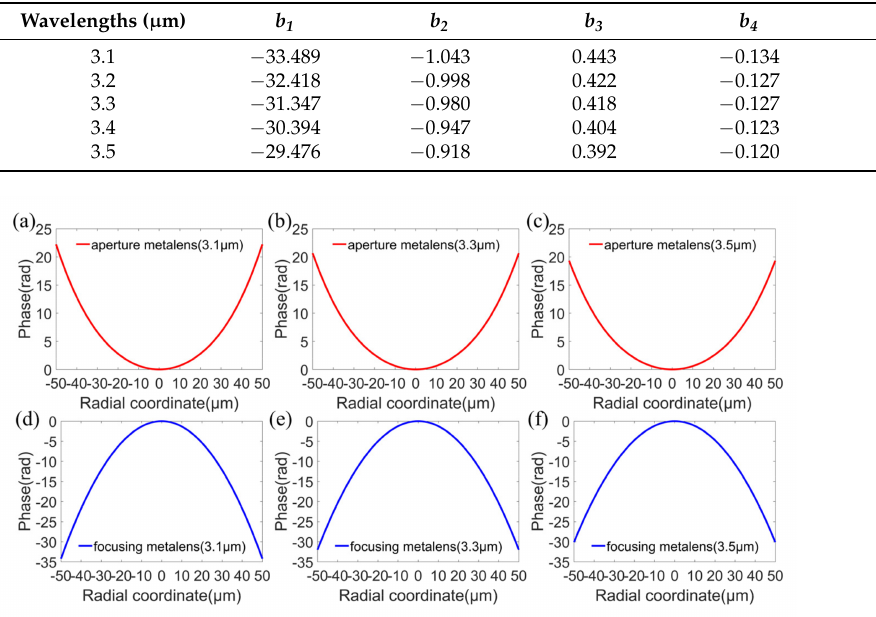
Figure 3. Phase profiles of the aperture metalens ( a – c ) and focusing metalens ( d – f ) at wavelengths 3.1 µ m (lower limit of operating band), 3.3 µ m (center wavelength), and 3.5 µ m (upper limit of operating band),